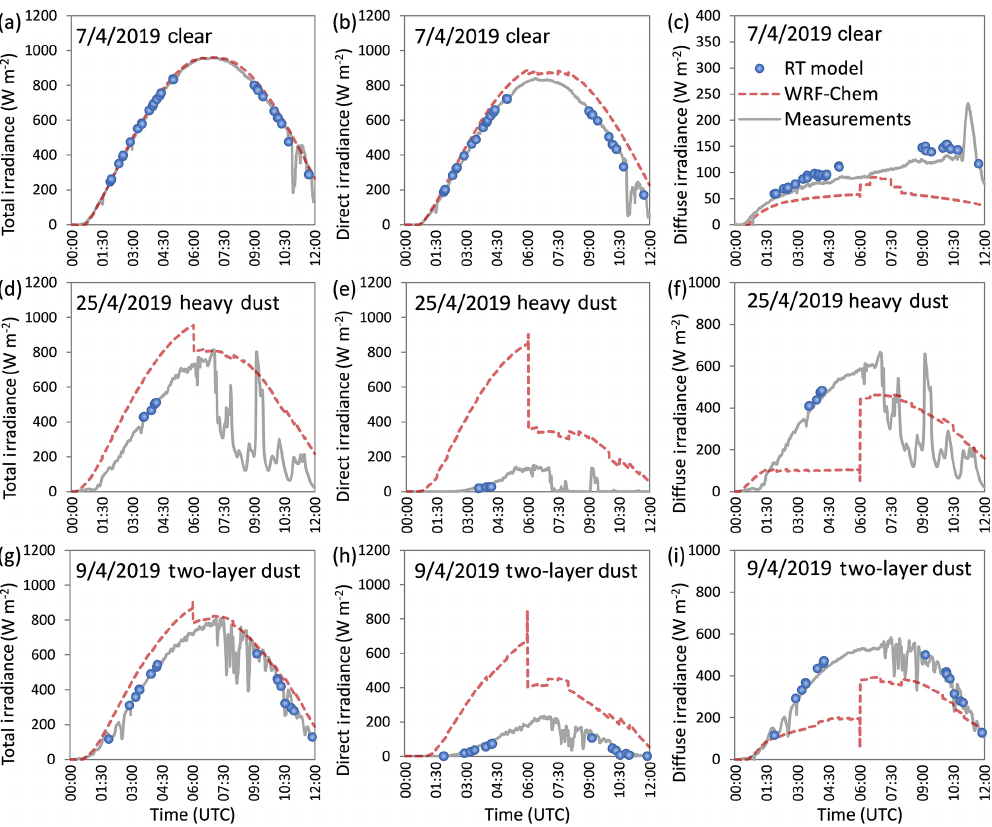
Figure 14. Comparisons of total, direct, and diffuse downward irradiances at the bottom of atmosphere for the clear-sky case (a–c) , the heavy dust case (d–f) , and the two-layer dust case (g–i) at the Kashi site (blue points: simulated by the RT model; dashed red lines: simulated by the WRF-Chem model with data assimilation at 00:00 and 06:00UTC; solid gray lines: measured by pyrheliometer and